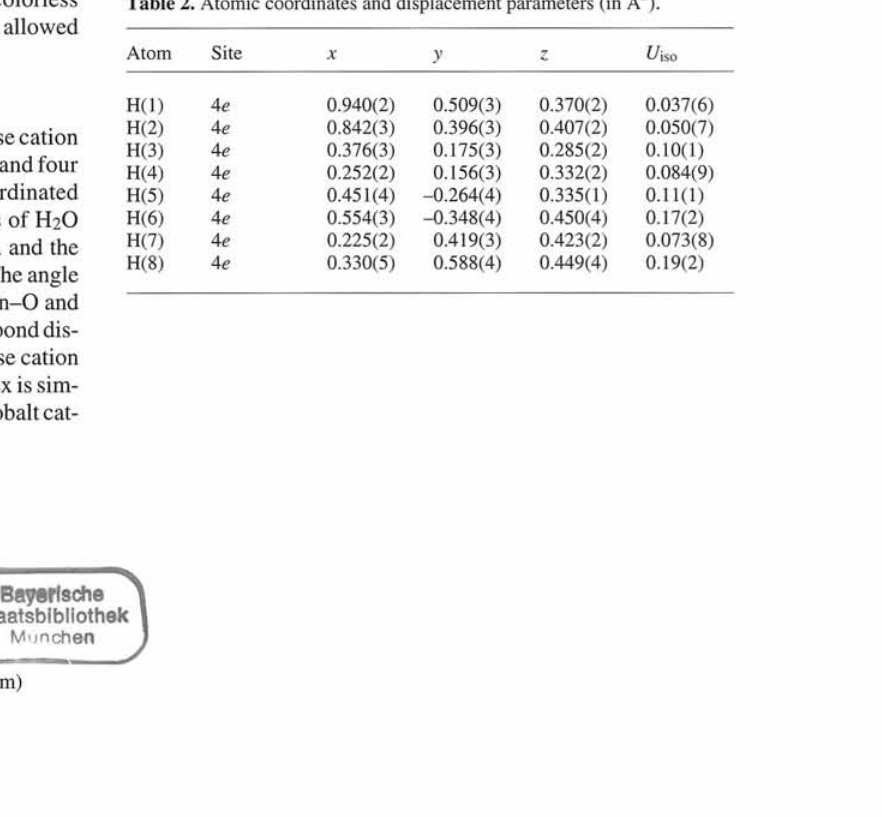
Table 2. Atomic coordinates and displacement parameters (in